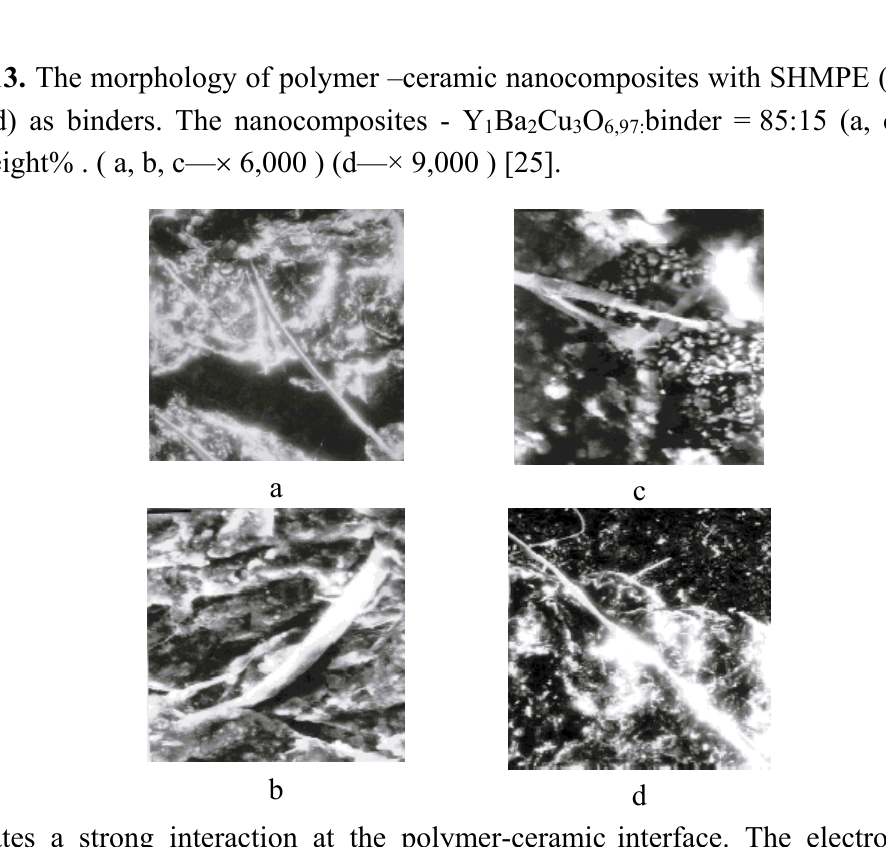
Figure 13. The morphology of polymer –ceramic nanocomposites with SHMPE (a, b) and iPP (c, d) as binders. The nanocomposites - Y